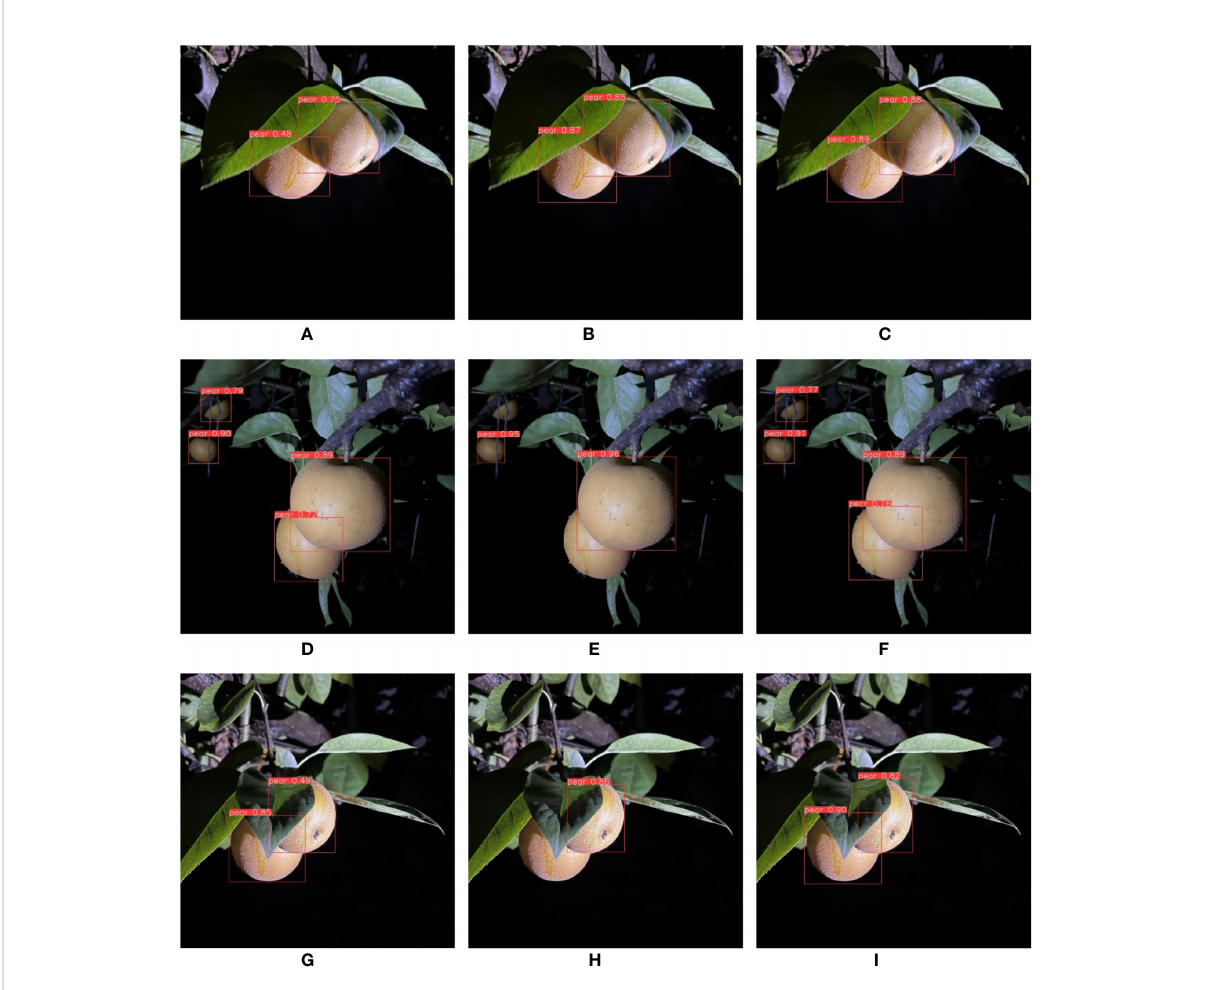
FIGURE 11 From left to right are the detection effects of YOLOv5s, MobileNet-YOLO and YOLO-P. (A – C) No shaded or slightly shaded; (D – F) Medium shaded; (G – I) Serious